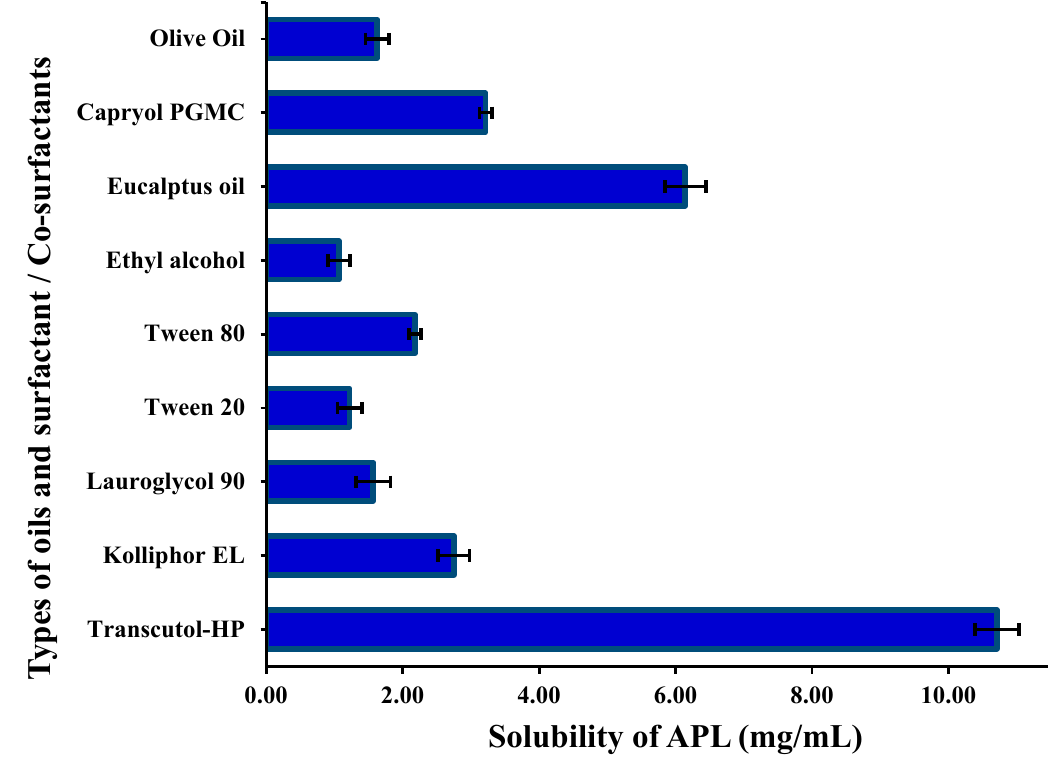
Figure 1. Phase solubility of apremilast in various oils, surfactant, and co-surfactants.